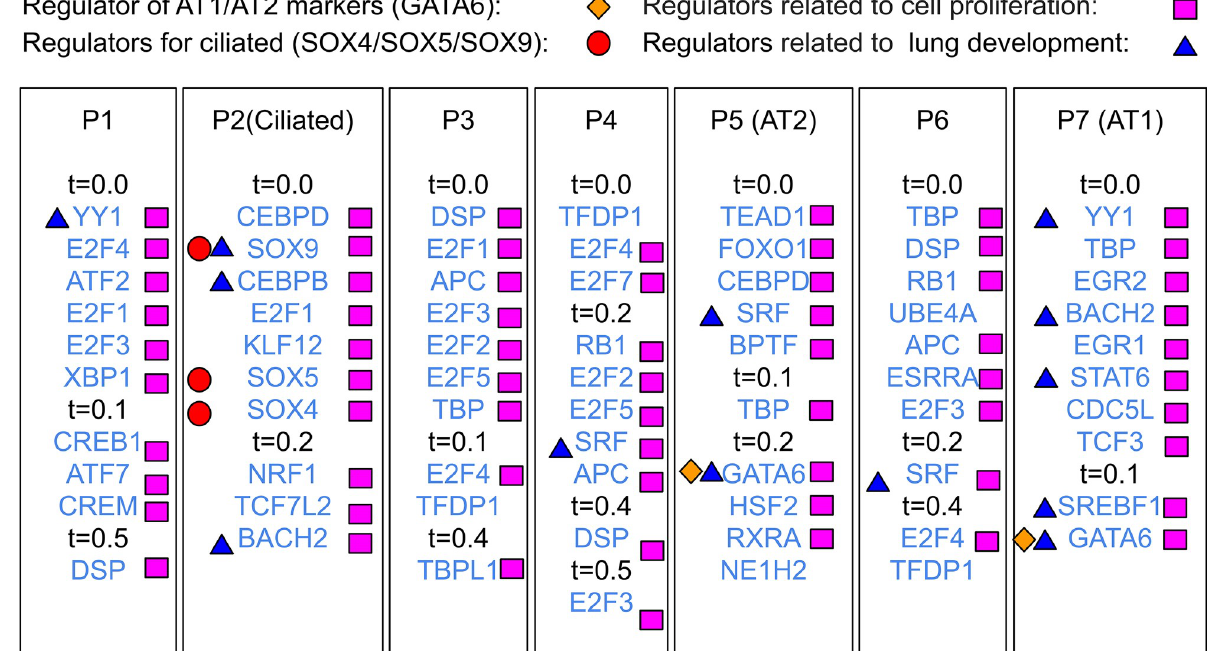
PLOS Computational Biology | https://doi.org/10.1371/journal.pcbi.1007644 February18,